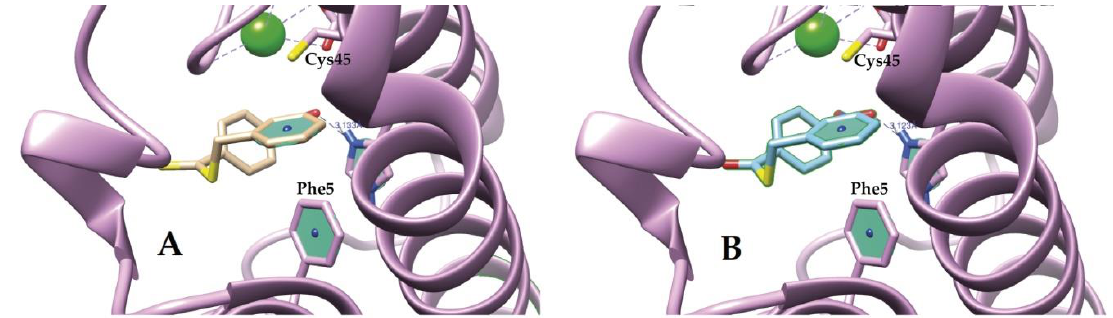
Figure 5. Benzyl ring contacts of I ( A ) and II ( B ) with Phe5 (π-π T shaped interaction) and with the sulfur atom of Cys45 (π-sulfur interaction).